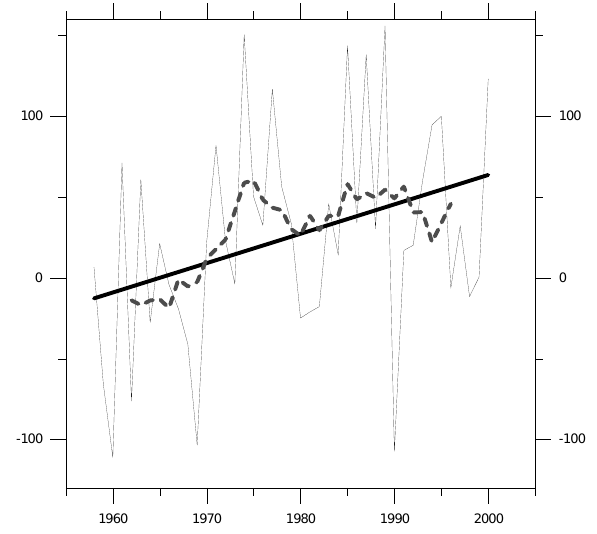
Fig. 8. Regional evolution of mean geopotential height perturba- tions (m) over Southern Europe (40 ◦ N, 10 ◦ E) at the 300-hPa layer Figure 8: Regional evolution of mean geopotential height perturbations over Southern Europe for December. Linear regression with time (trend, straight line) and (40° N, 10° E) at 300 hPa layer for December. Linear regression with time (m/yr) (trend, 9-year running mean (decadal change, dashed straight line) and 11 year running mean (decadal change, dashed line).